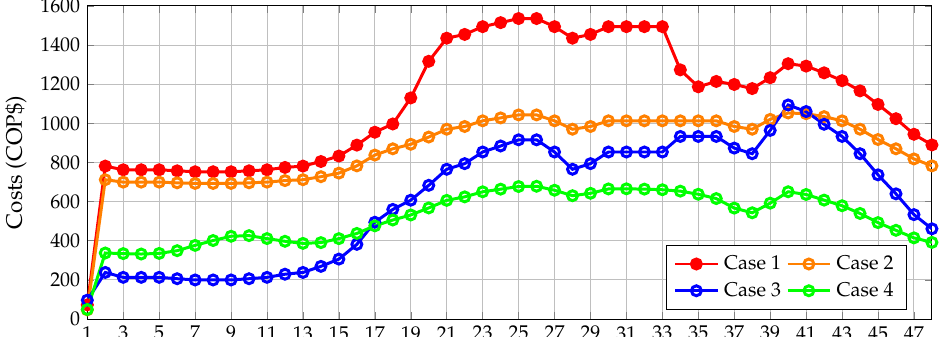
Figure 4. Daily behavior of the energy losses costs in the 21-bus grid as a function of the location of the distributed energy